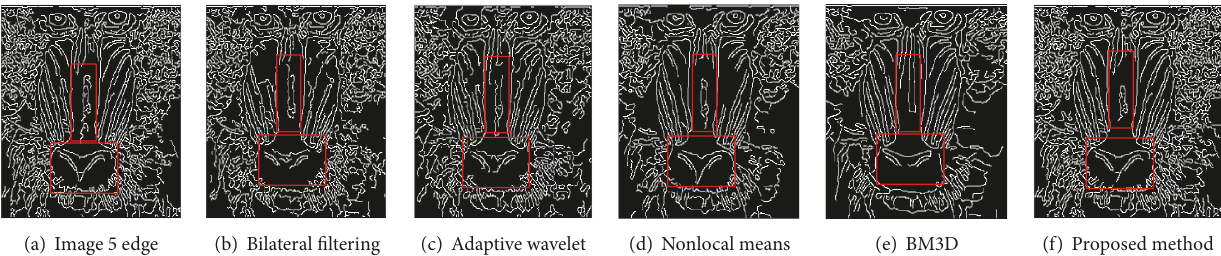
Figure 14: Image 5: edge comparison of various experimental results under noise variance 𝜎 2 = 0.01 .